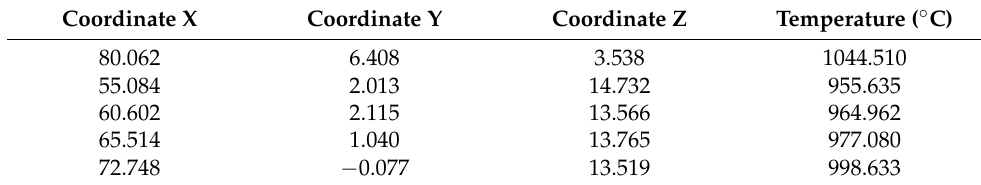
Figure 6. Temperature fields of the turbine blade of the iSTC-1v jet engine computed using ANSYS CFX software. Table 2. Estimated temperatures using ANSYS CFX software for the chosen nodes of the